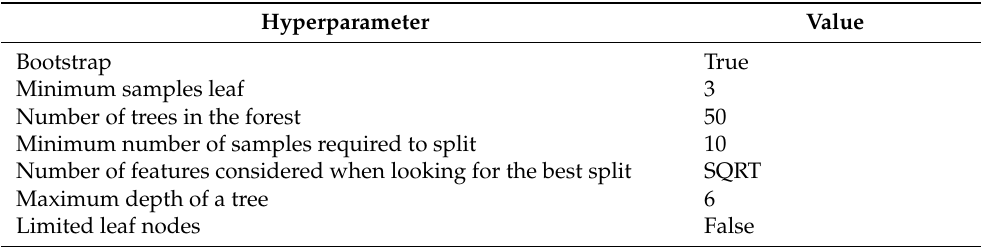
Table 5. Random Forest model